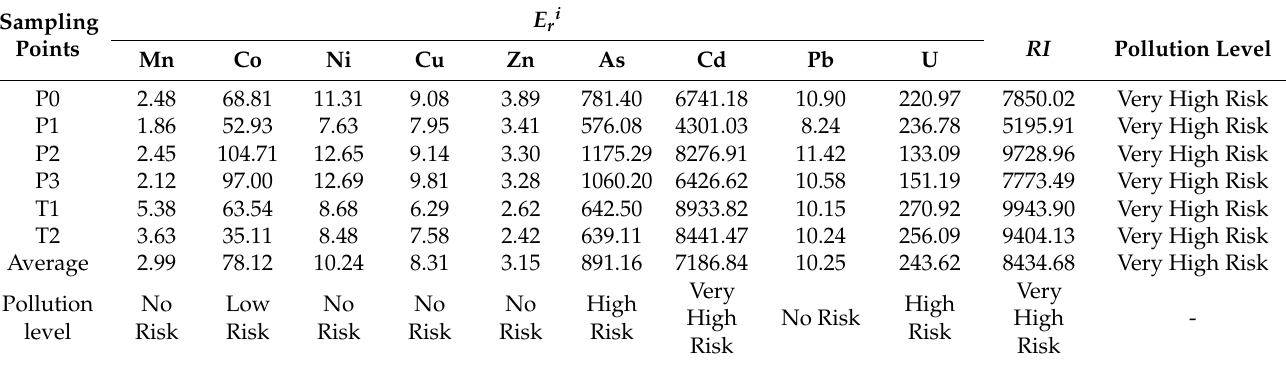
Table 8. Statistical table of ecological risk assessment of soil uranium and heavy metals in a uranium mining area in northern